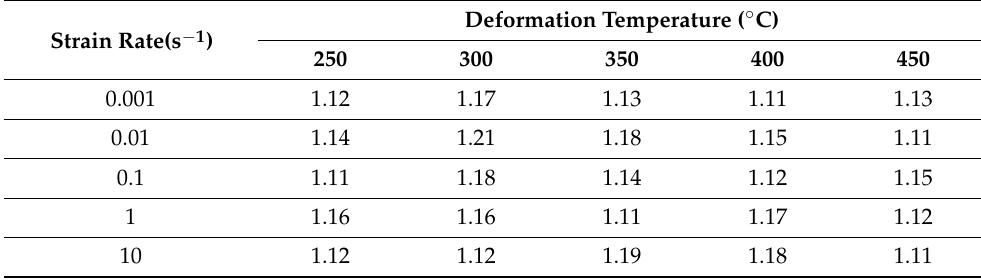
Table 3. Expansion coefficient B of F92 steel under different deformation